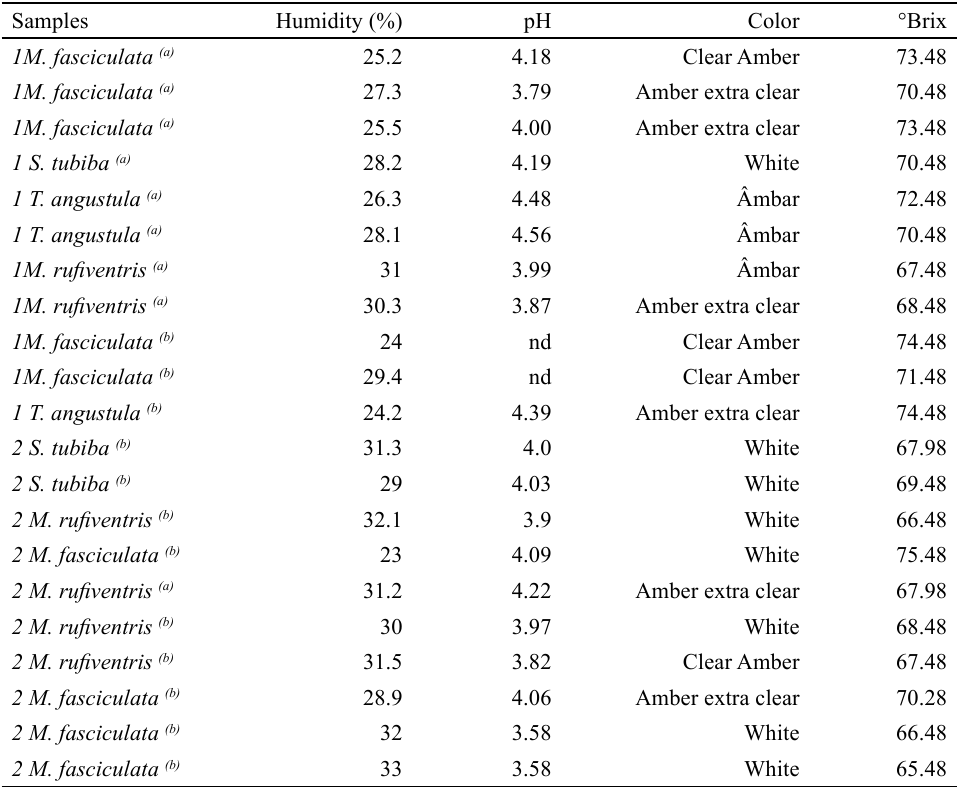
Table 4 - Analysis of moisture, pH, color, and total soluble solids (°Brix) for honey collected by the four melipona species in the municipalities of Palmas and Miracema during the two collections